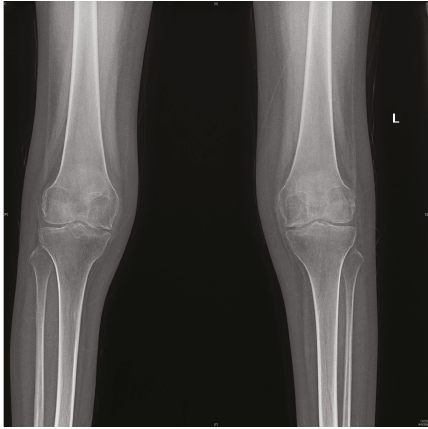
Figure 2: Plain knee radiographs at age 19.